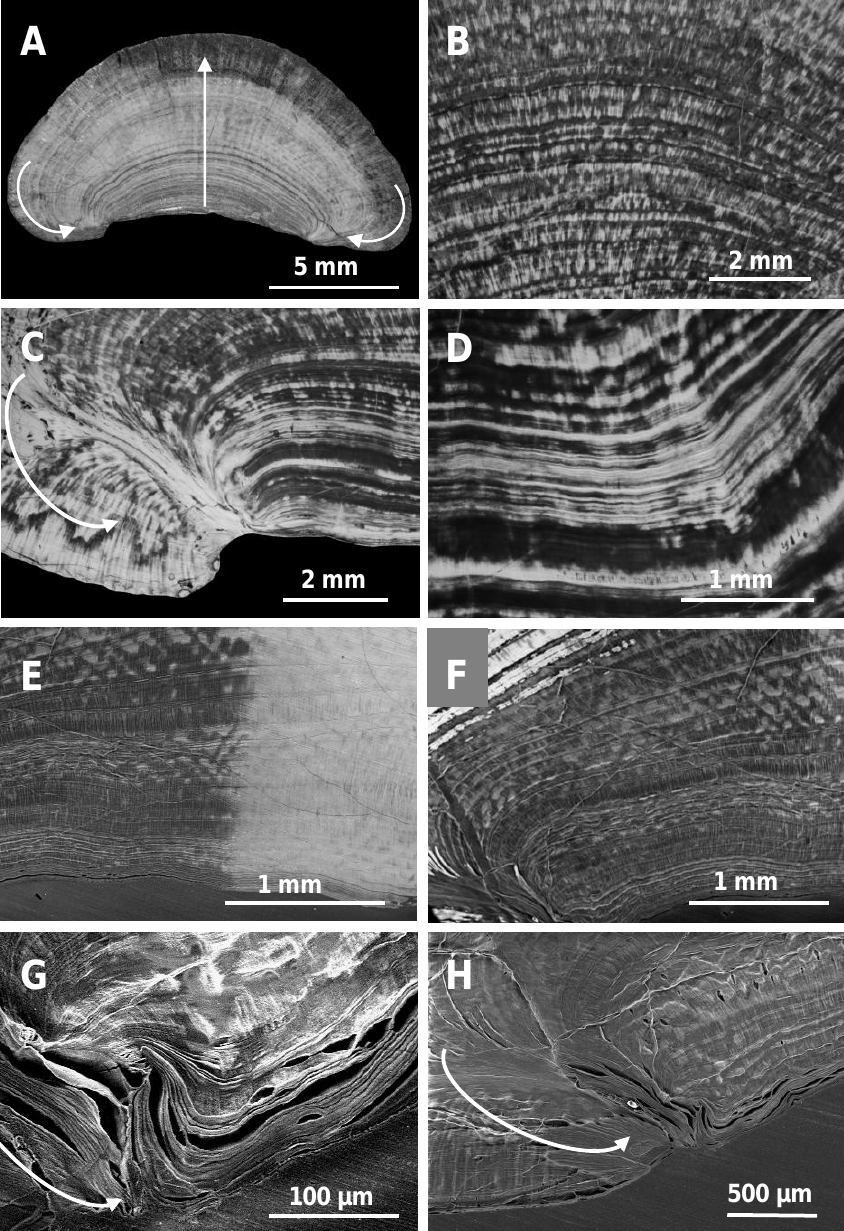
Figure 2. Cross-section of a Cherax quadricarinatus gastrolith showing an irregular layered structure. A–D: Light microscopy, without any treatment. A: cross-section of a whole gastrolith. The central arrow indicates the growing direction, the lateral arrows indicate the lateral covering process occurring at the end of the storage in late premolt. B–D: magnification of different areas of a cross-section. Dense calcium carbonate layers of different widths alternate with less dense layers. E–H: (E–F: Light microscopy, G–H: SEM) the presence and direction of organic matrix layers are clearly shown after partial surface decalcification (grey areas; the bright areas correspond to the native